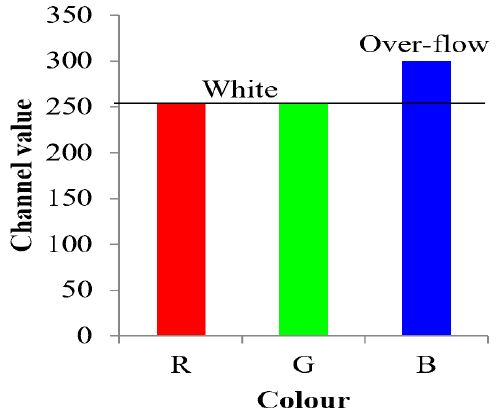
Figure 18. RGB values of a pixel.